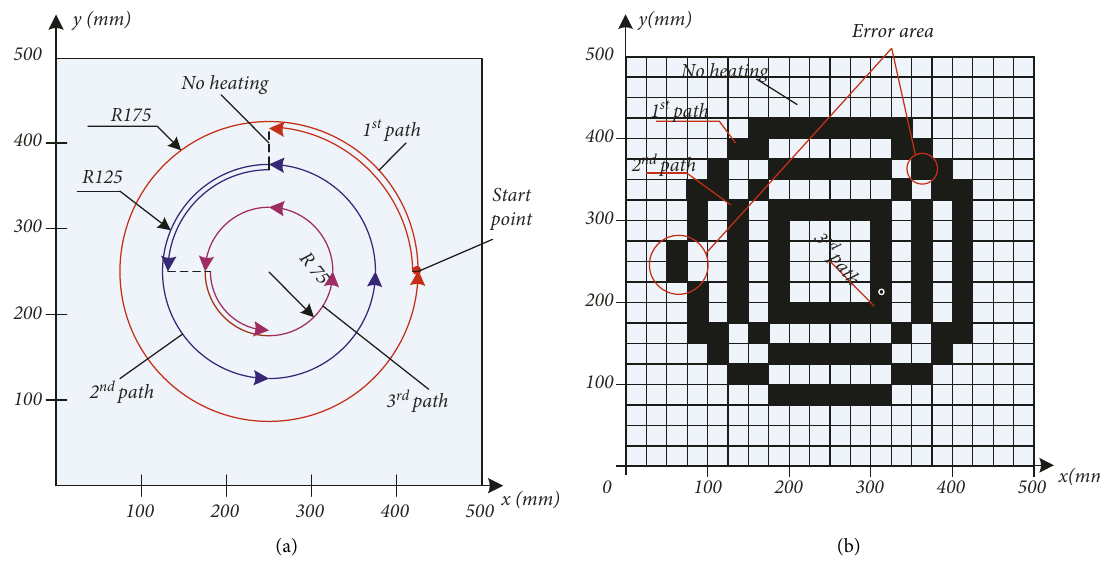
Figure 13: (a) Target trajectories of the heat inductor and (b) predicted heating regions errors by